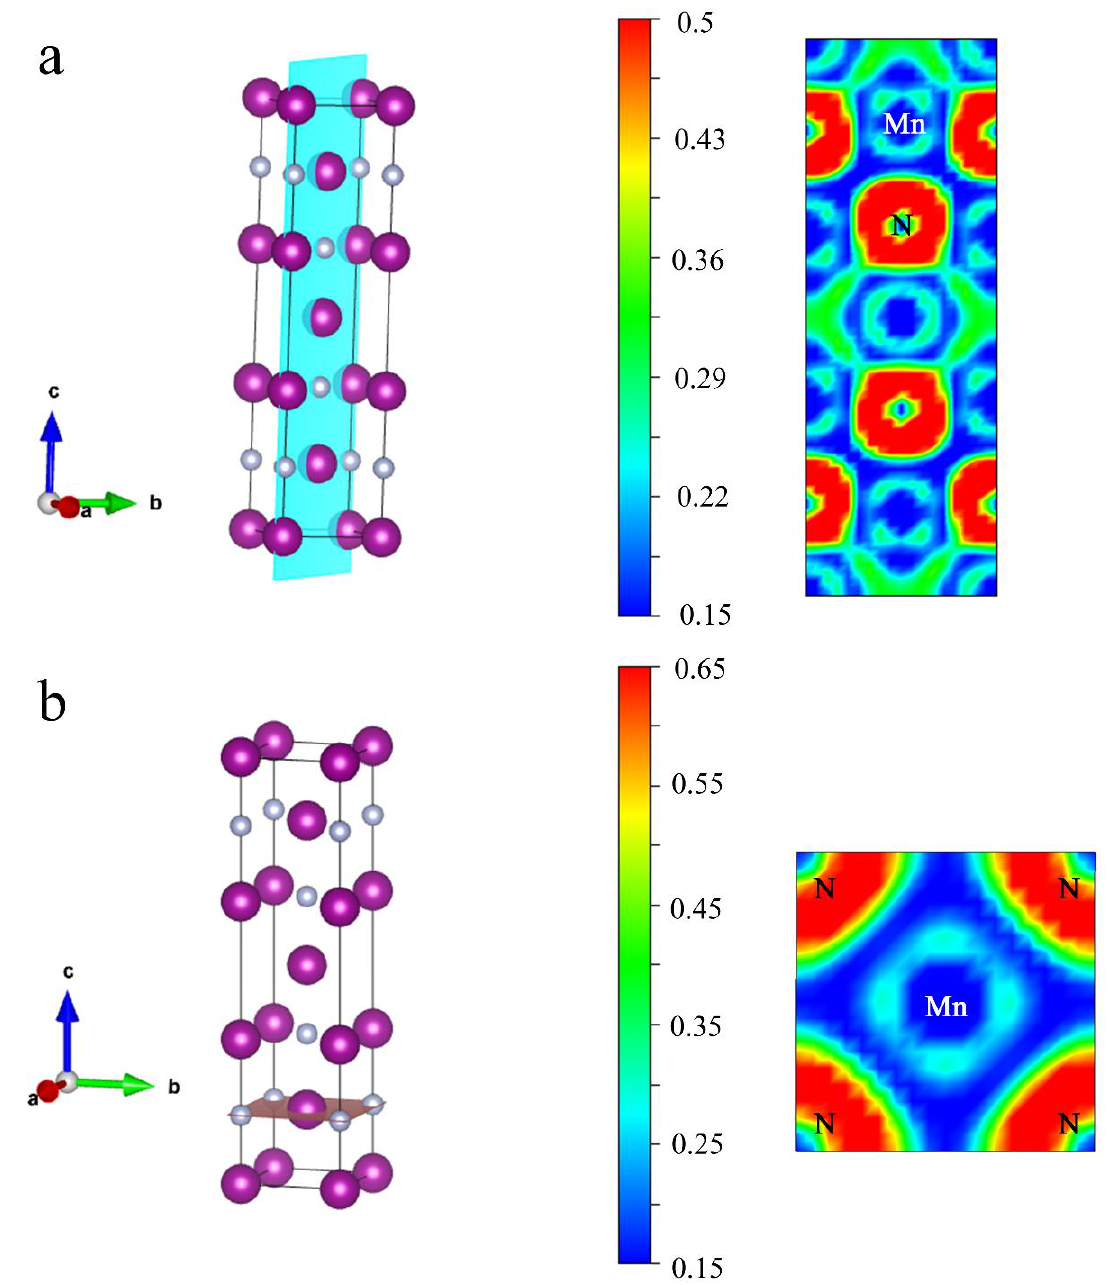
Figure 6. Electronic localization function for Mn 3 N 2 . ( a ) Cutting along the (110) crystal plane with cyan and ( b ) cutting along the (001) crystal plane with caramel. Purple balls are Mn atoms, white ball are N atoms.